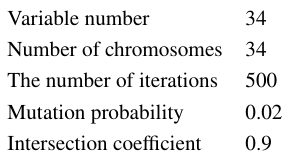
Table 7 NSGA-II parameters used for optimal design of three loops with no-leak WDN